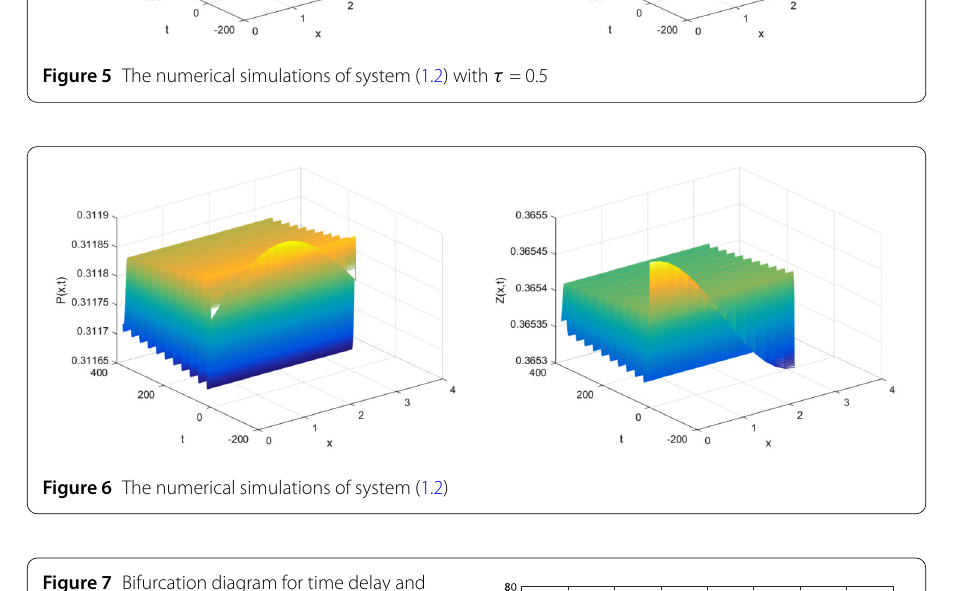
Figure 7 Bifurcation diagram for time delay and constant